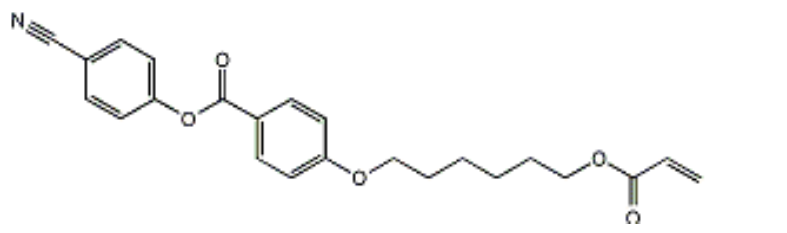
Figure 1. Chemical structure of 4-[6-(Acryloyloxy)hexyloxy]benzoic acid=4-cyanophenyl ester included in the